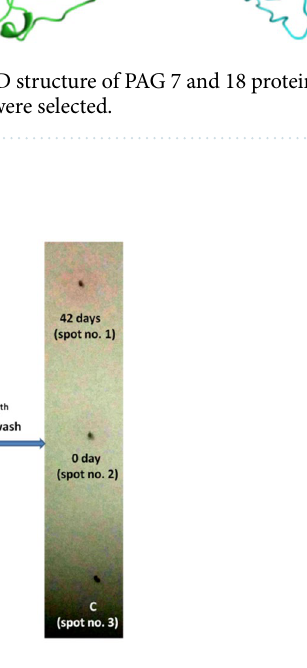
Figure 6. Gold nanoparticle based detection of PAG protein by aptamer PAG7_2.